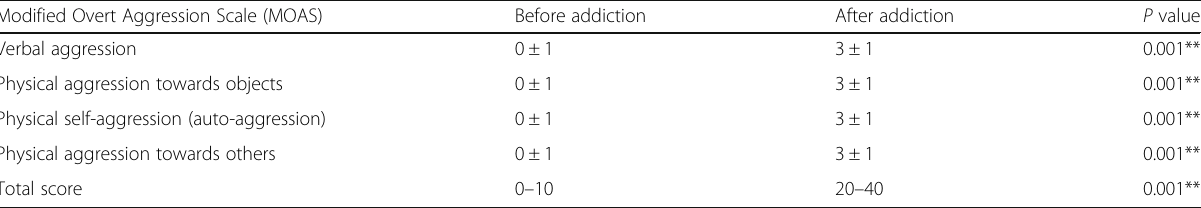
Table 4 Modified Overt Aggression Scale (MOAS) (Modified Overt Aggression Scale) in patients, before and after addiction Modified Overt Aggression Scale